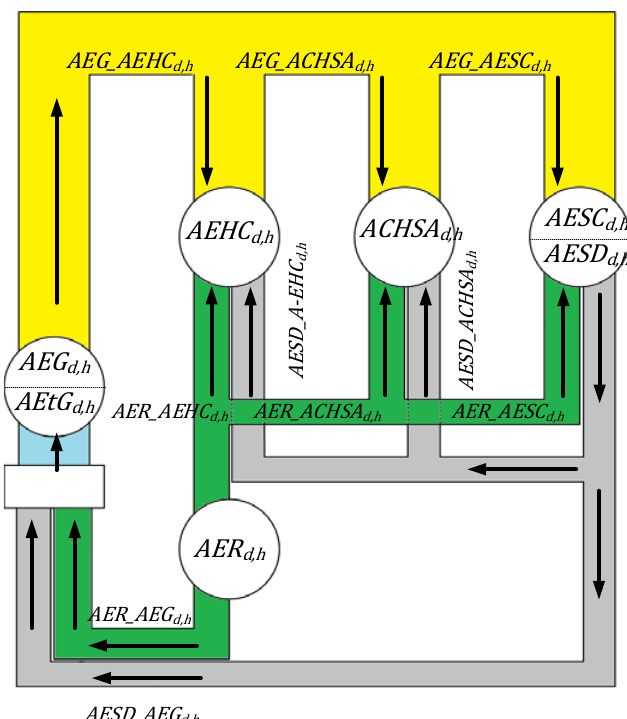
Figure 3. Representation of the physical model of the of the energy community. Source: self- elaboration.